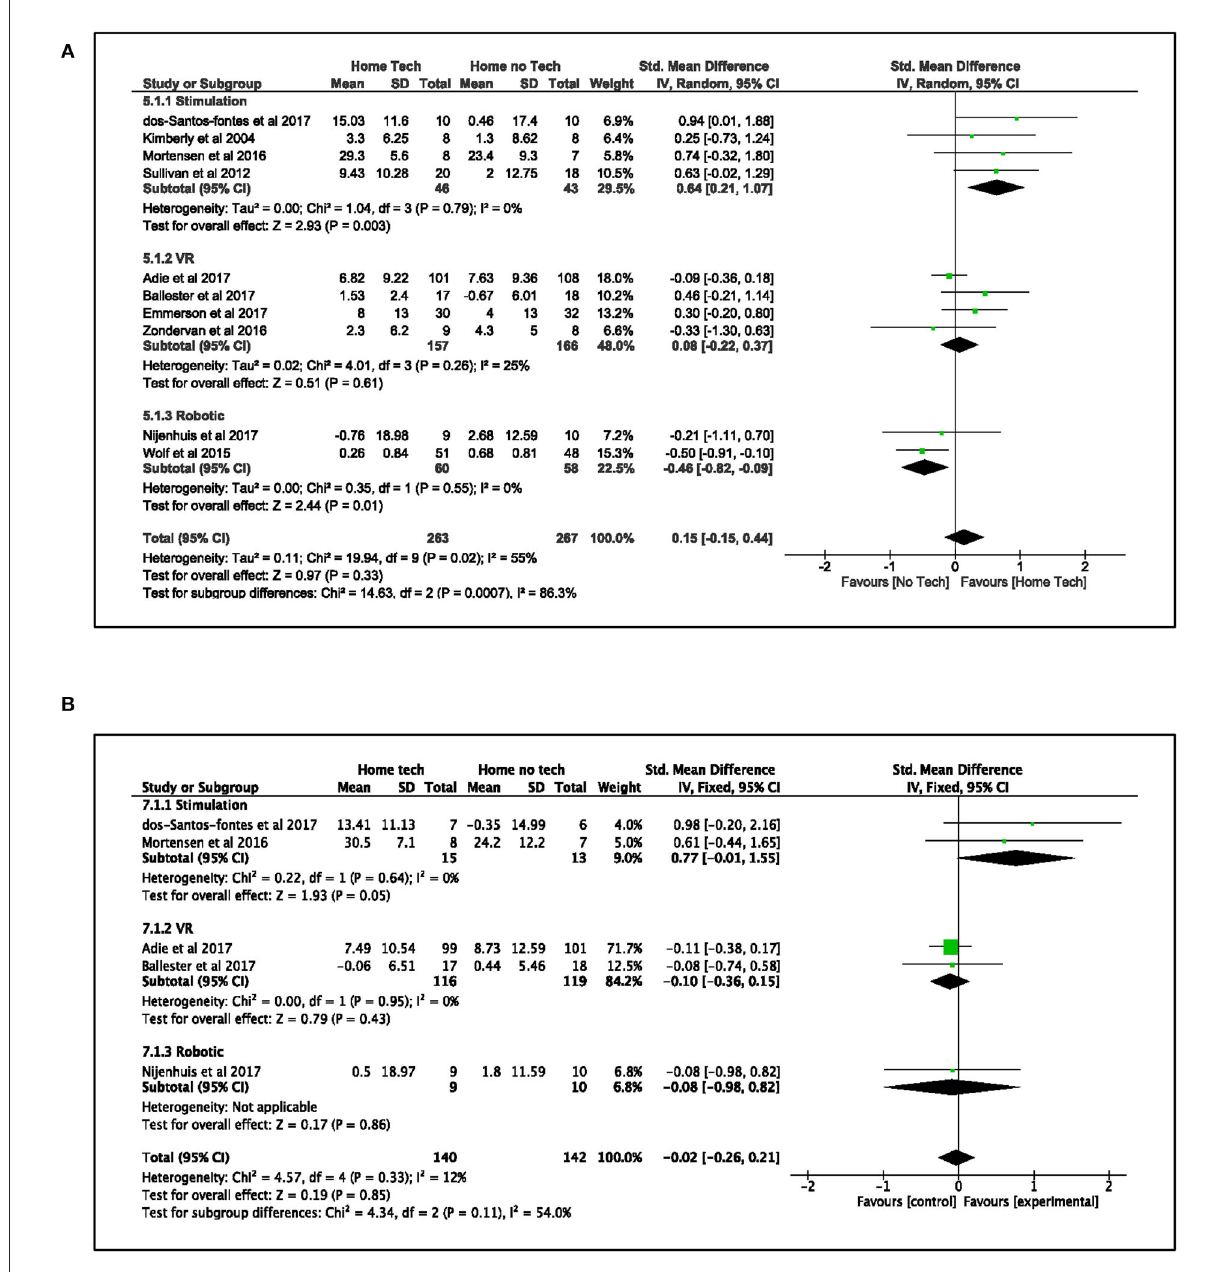
FIGURE4 Comparison of the effect of technology-assisted home-based intervention and “no technology” intervention on UL function (A) standardized mean difference (SMD) immediately after treatment. (B) Standardized mean difference (SMD) at follow-up.